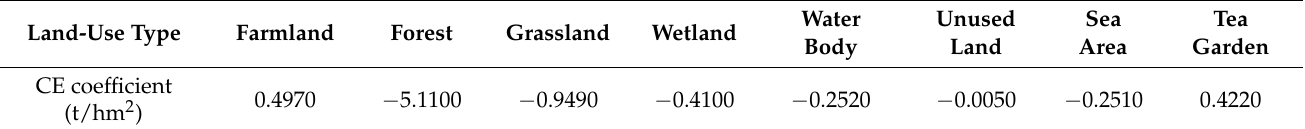
Table 4. Land-use type carbon emission factor. (Emissions are positive, and absorptions are negative.)